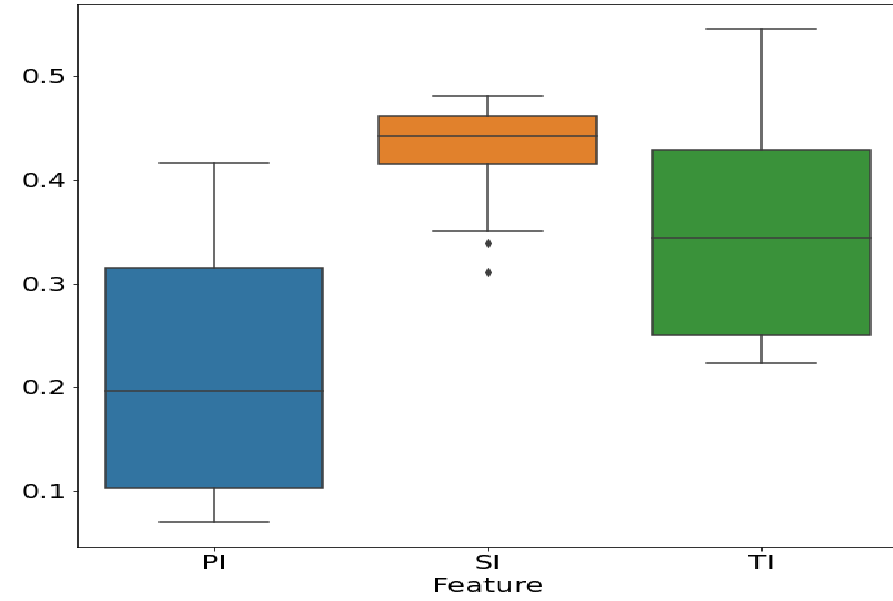
Figure 4. Distribution of PI, SI and TI. ◆ indicates an outlier.